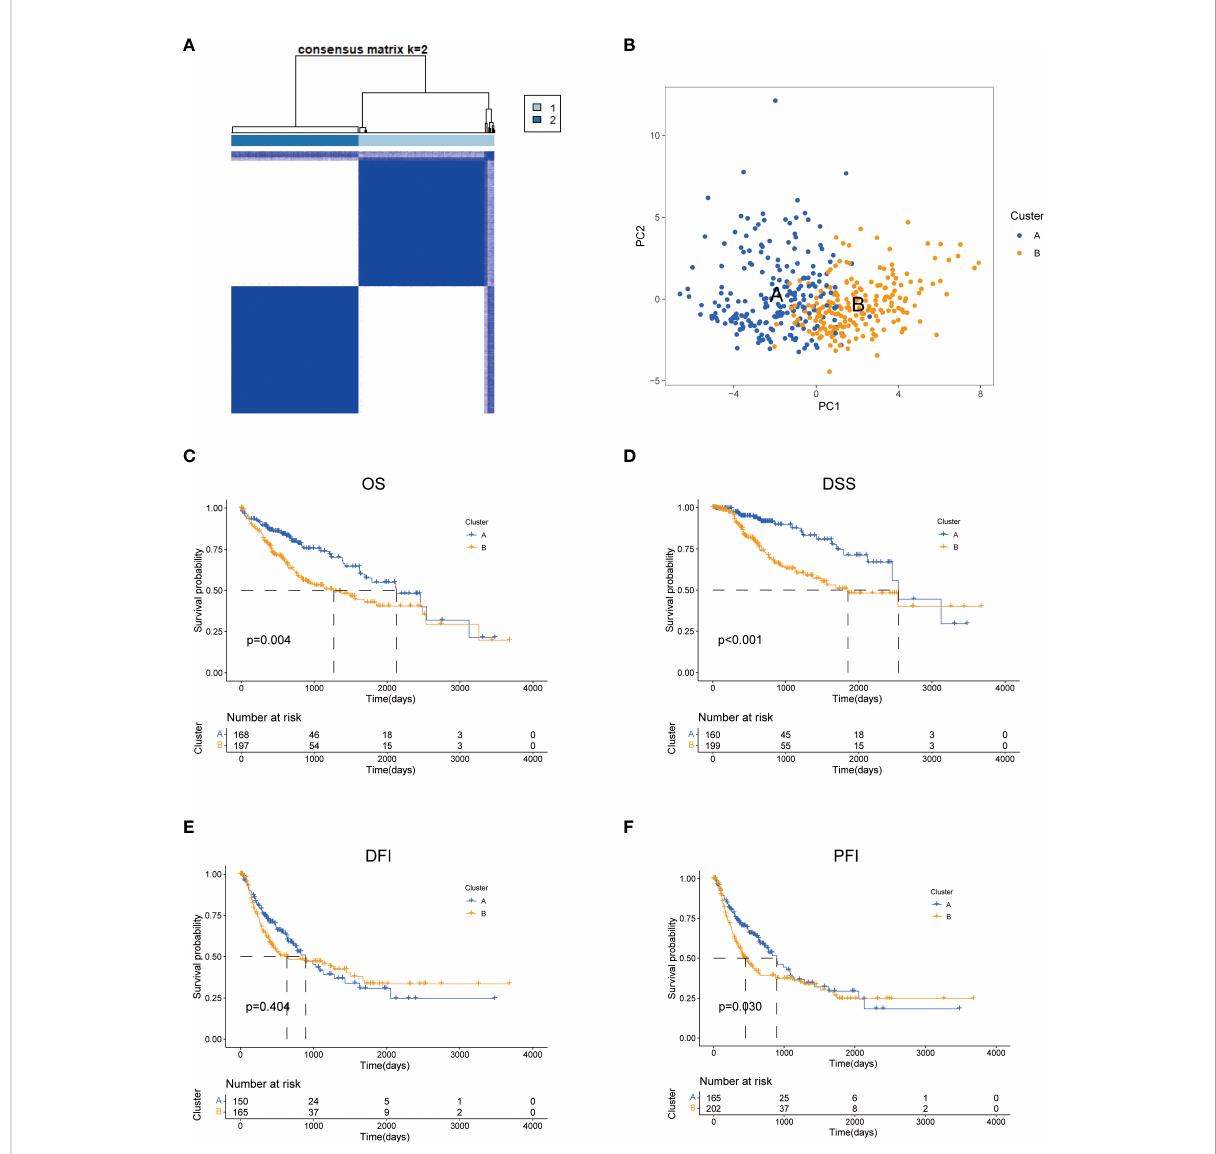
FIGURE 2 Characteristics of two TRGs subtypes divided by consistent clustering. (A) Consensus heatmap matrix and correlations areas of two clusters (k = 2). (B) PCA analysis demonstrates a distinctive difference between the two clusters. Univariate analysis shows 44 TRGs related to the OS (C) , the DSS (D) , the DFI (E) , and the PFI (F) . OS, overall survival; DSS, disease-speci fi c survival; DFI, disease-free interval; DFI, progression-free